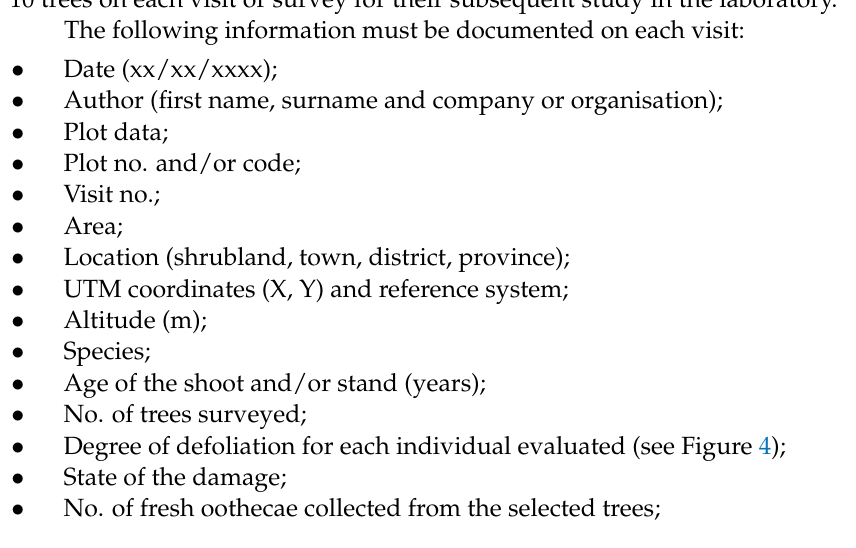
Table 3. Degrees of defoliation according to the GOSSGE protocol .